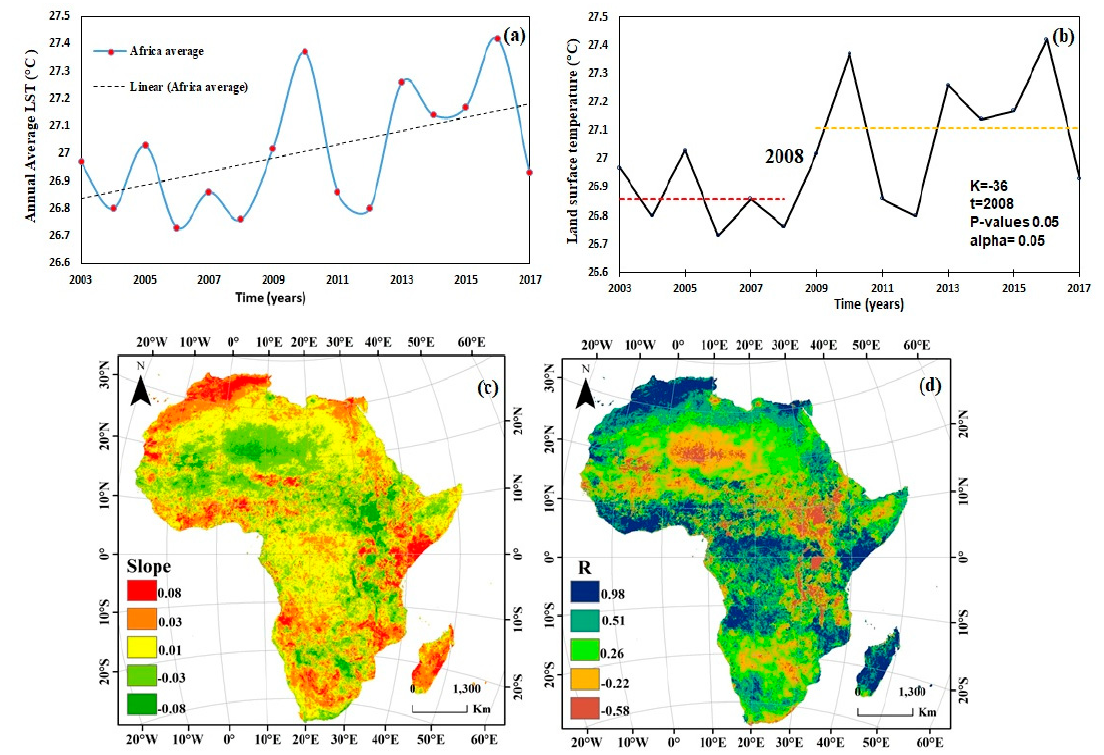
Figure 4. Spatial distributions of annual LST in Africa: ( a ) mean LST, ( b ) Pettitt test, ( c ) slope, ( d ) correlation coefficient from 2003 to 2017.